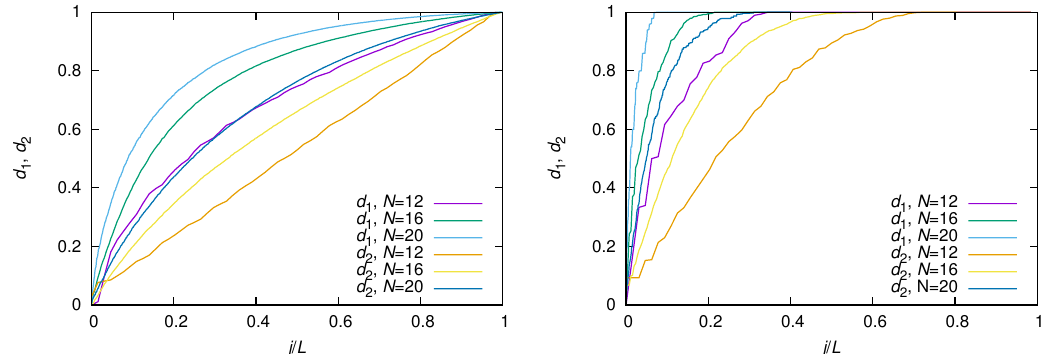
Figure 3 . The generalized Majorana SYK model. d 1 and d 2 vs j=L . Averages over 50 samples ( N = 12 ; 16) and 5 samples ( N = 20). [Left] K = 0 : 01, [Right] K =